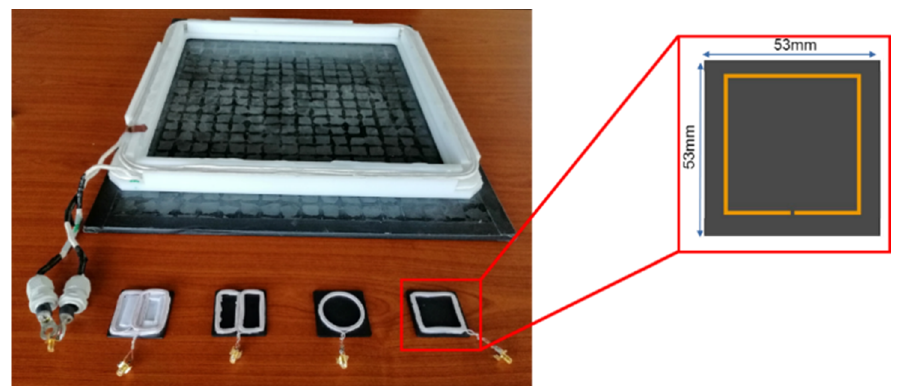
Figure 20. Miniaturized prototypes made in the laboratory.